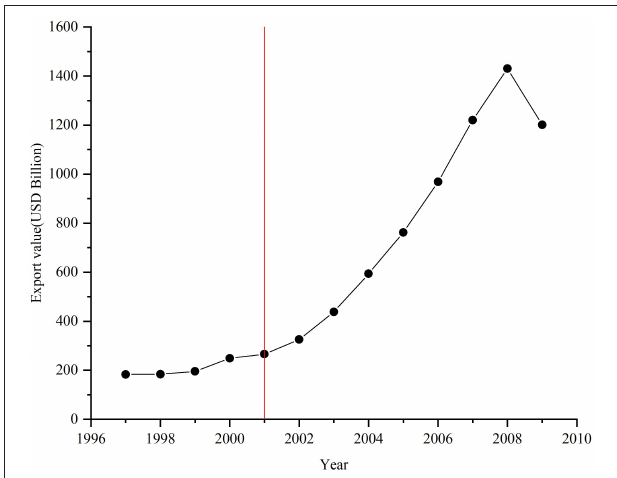
FIGURE 1 | Export value in China between 1997 and